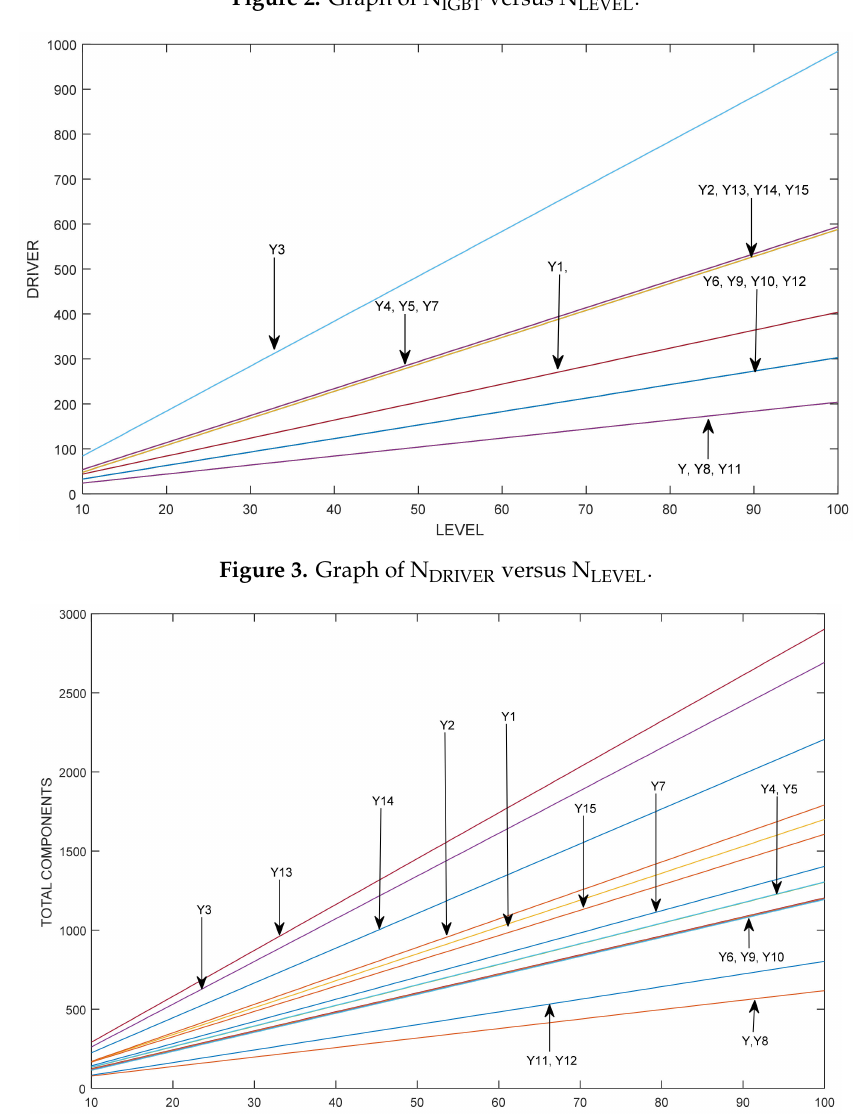
Figure 2. Graph of N IGBT versus N LEVEL .